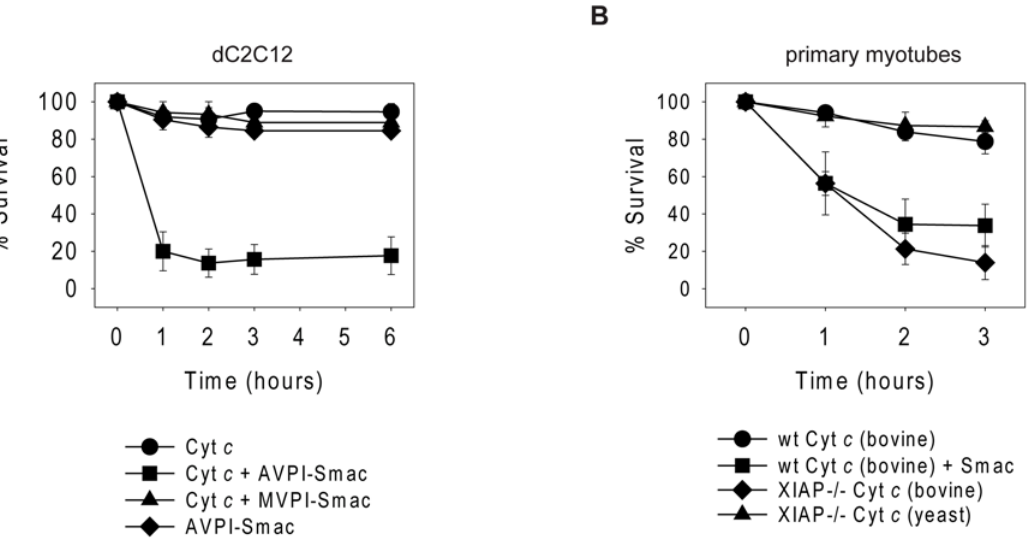
Figure 2. Resistance to cytosolic cytochrome c is mediated by endogenous XIAP. (A) dC2C12 cells were injected with rhodamine dextran and either bovine cytochrome c , wildtype AVPI-Smac, mutant MVPI-Smac or AVPI-Smac and cytochrome c together. (B) Primary wildtype (wt) myotubes were injected with rhodamine dextran and bovine cytochrome c or AVPI-Smac and bovine cytochrome c . XIAP-deficient (XIAP-/-) myotubes were injected with rhodamine dextran and either bovine or yeast cytochrome c . Cell survival was assessed by morphology at the indicated times following injection. Data are the mean 6 SEM of n $ 3 separate experiments per time point.